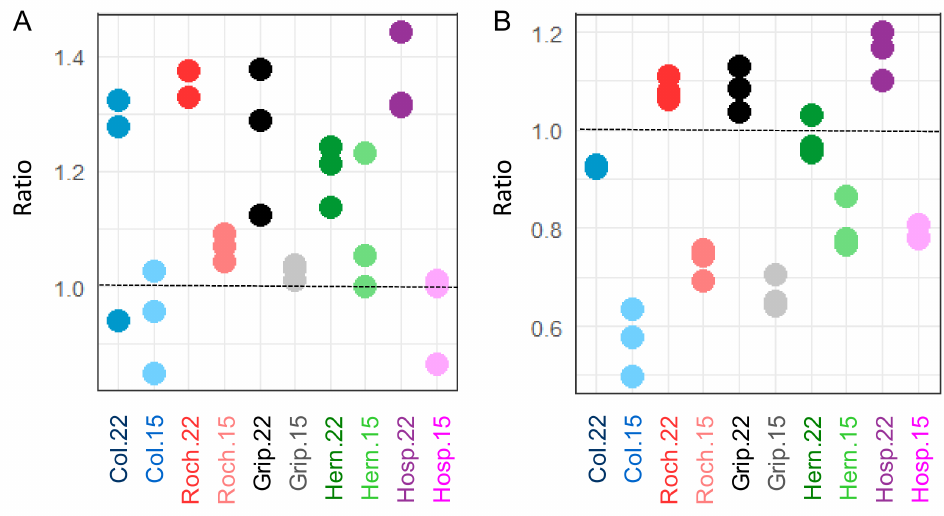
Figure 3. Ratios of linear to branched pectins of Col, Roch, Grip, Hern and Hosp grown at 22 or 15 ◦ C: ( A ) rosettes; ( B ) floral stems. Mean values calculated from 3 independent batches are